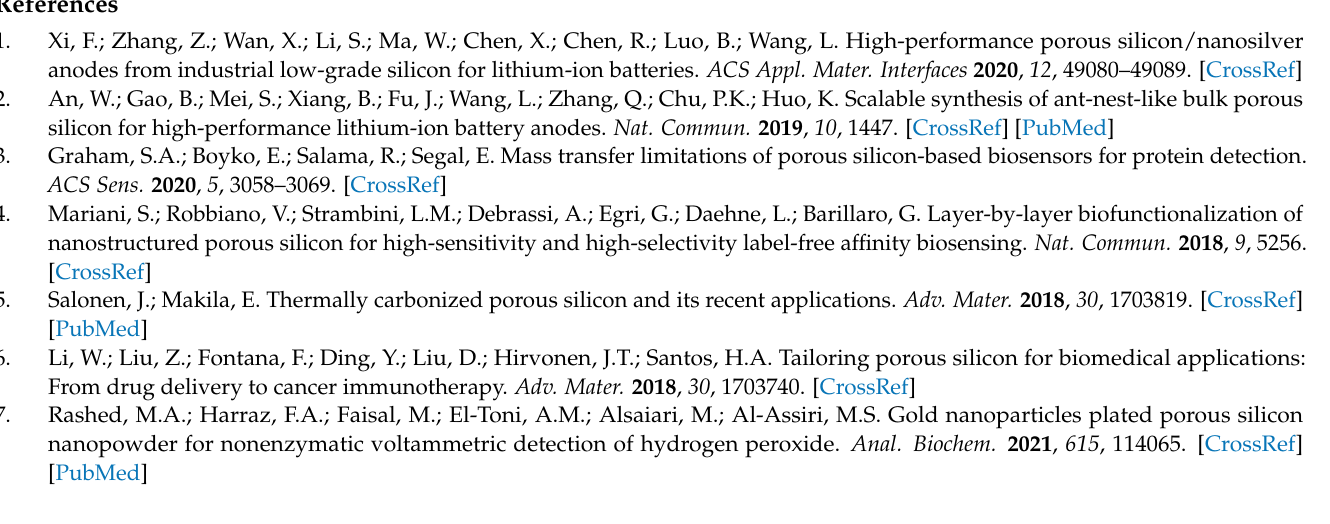
chemical etching; Figure S2: (a) SEM image of PSi films (a 65 × 65 µ m 2 patterned substrate covered with ~120 nm Ag reaction in the etchant with R = 6:4 for 30 min). (b) Corresponding distribution histogram of pore size; Figure S3: Corresponding pore size distribution histograms of PSi films with different porosity (a) 74%, (b) 68%, (c) 34%, (d) 25%, and (e) 16% (corresponding to Figure 2a–e); Figure S4: (a,b) Model of the formation of horizontal cracks of PSi films during drying. (c) SEM image of PSi films with horizontal cracks; Figure S5: (a) Raman spectra of 10 − 4 M 4-MBT on PSi SERS substrates, (b) Raman spectra of pure powder of 4-MBT on Si substrate; Figure S6: SEM images of PSi films (a) before and (b) after transfer onto flexible tape coated with 40 nm Ag film; Figure S7: Raman spectra of R6G on the prepared SERS substrate at various CR6G ranging from 10 − 7 to 10 − 12 M; Figure S8: Raman spectra of the MPT residues on apple peels using flexible PSi films SERS substrate; Figure S9: SEM images of PSi films (a) before and (b) after 100 cycles of bending. (c) Raman spectra of 10 − 4 M 4-MBT collected on the flexible PSi films SERS substrate before and after 100 cycles of bending. References [45–47] are cited in the supplementary